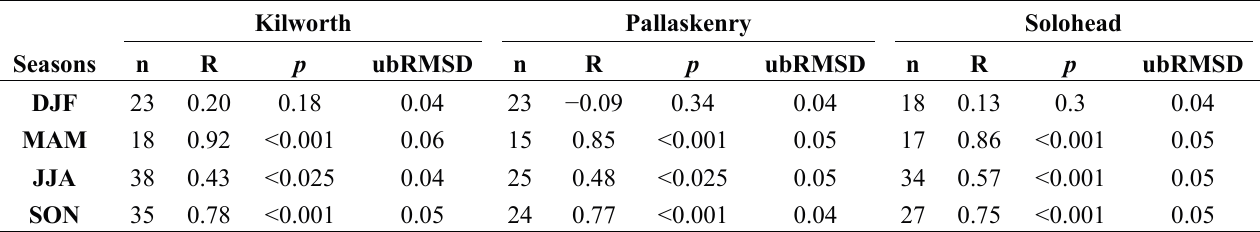
Table 6. Seasonal correlation (R) and unbiased RMSD (ubRMSD) between ECV and in situ SM datasets (winter: DJF; spring: MAM; summer: JJA; autumn: SON). The number of available data (n) and the p -values ( p ) are also